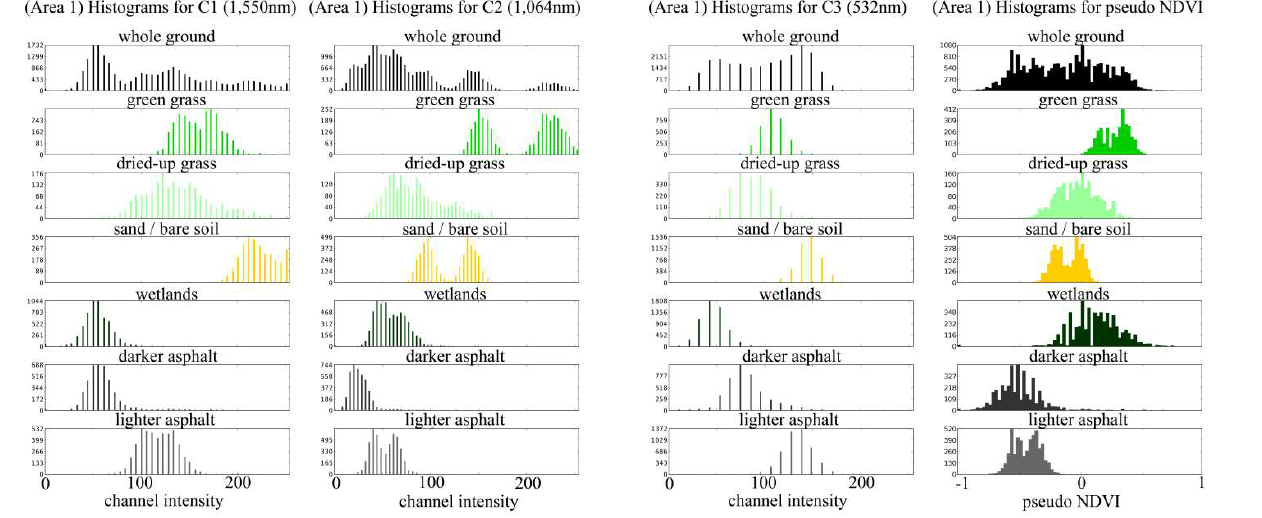
Figure 5. Class specific 8 bit scaled channel histograms for 1,550 nm and 1,064 nm wavelength laser signals (counts/bin) An exception is the wrong classification of second, third and last returns as ‘wetlands’. Aggregating the group of sealed classes and the group of unsealed classes leads to high classification accuracies compared to the manually revised classes ‘sealed ground’ and ‘unsealed ground’. The user accuracy for the ‘unsealed ground’ class is 0.95 and the producer accuracy is 0.94. The user accuracy for the sealed class is 0.74 and the producer accuracy 0.77 (Table 1).